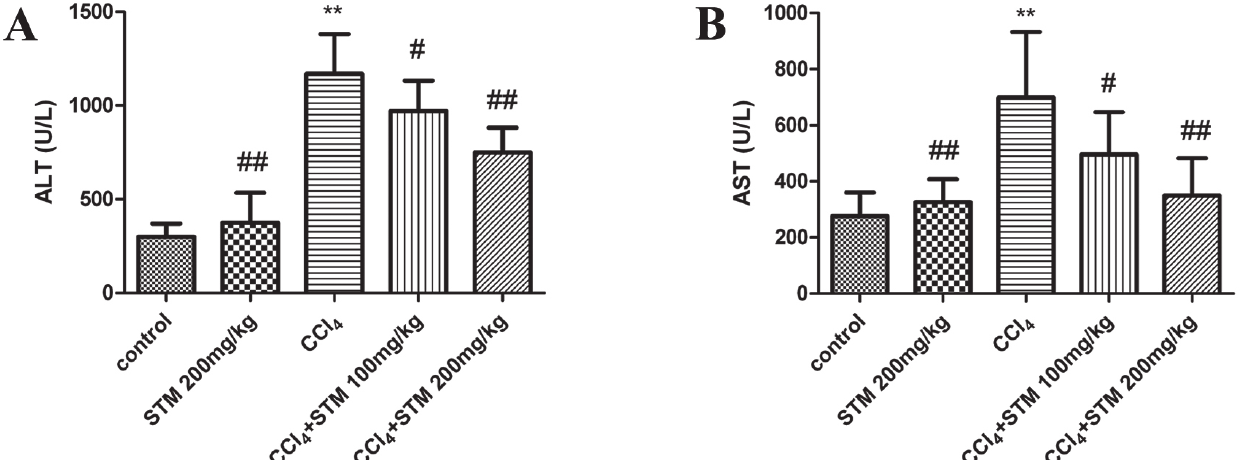
-induced changes in hepatic functional markers. (A) ALT activity; (B) AST activity. Data are FIGURE 2 - STM improved CCl 4 represented as means ± S.D. for 7-12 animals per group. * p < 0.05 versus control, ** p < 0.01 versus control; # p < 0.05 versus CCl ## p < 0.01 versus CCl by one-way ANOVA and LSD post hoc 4